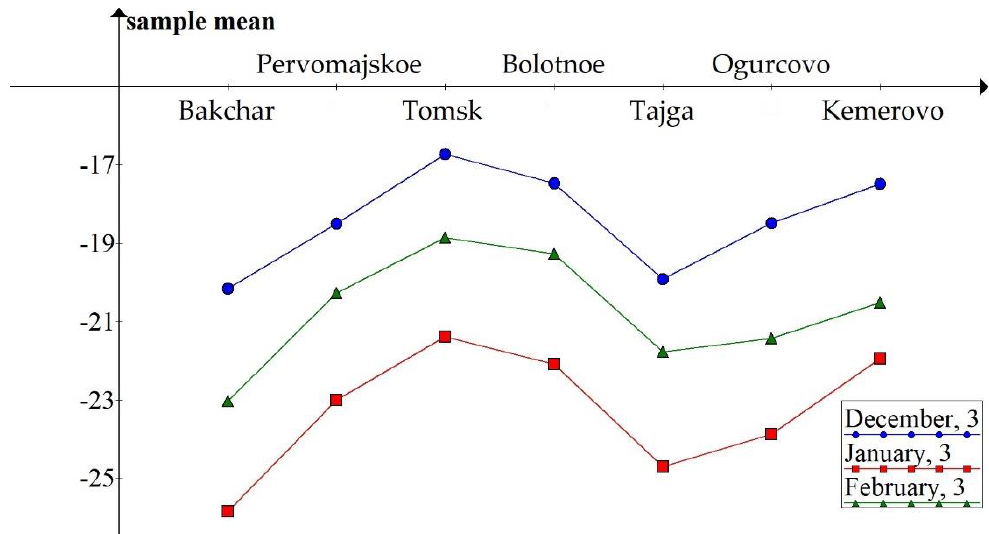
Figure 2. Sample mean of the average daily wind chill index (WCI), Area 1.